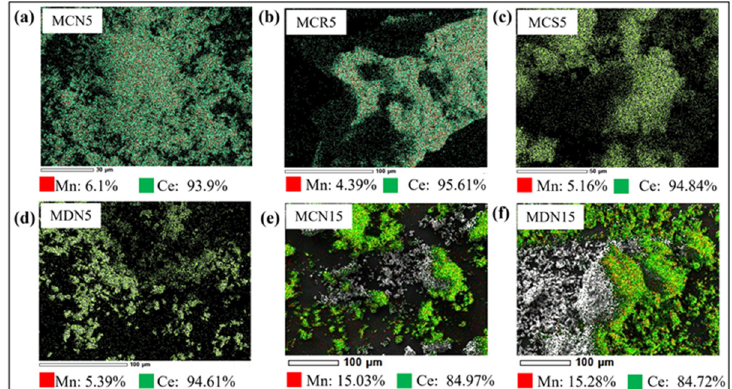
Figure 5. Analysis of scanning electron microscopy(SEM)/energy dispersive X-ray spectroscopy (EDS) of synthesized ( a ) MCN5, ( b ) MDN15, ( c ) MCS5, ( d ) MDN5, ( e ) MCN15, and ( f ) MDN15.